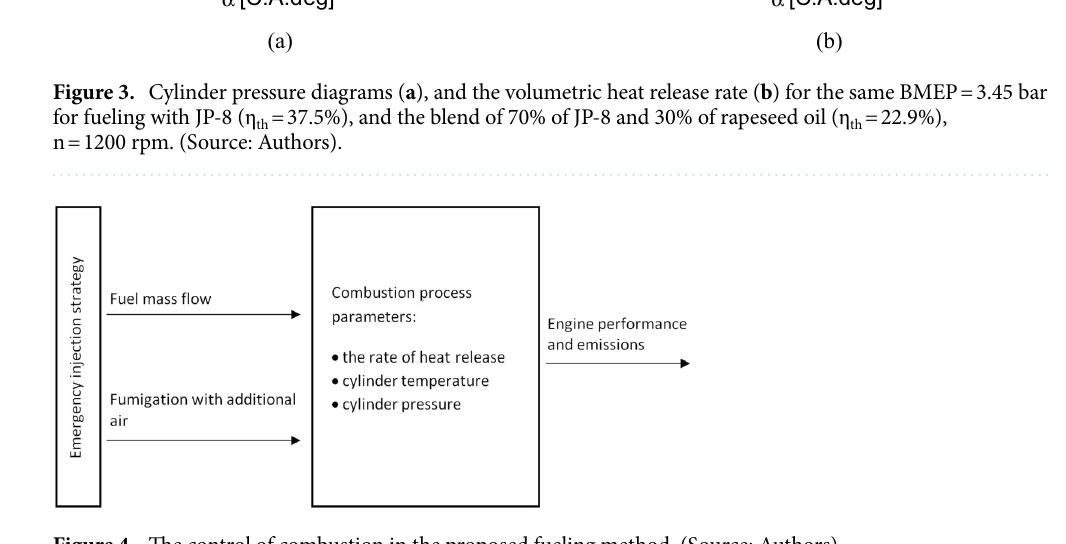
Figure 4. The control of combustion in the proposed fueling method. (Source: